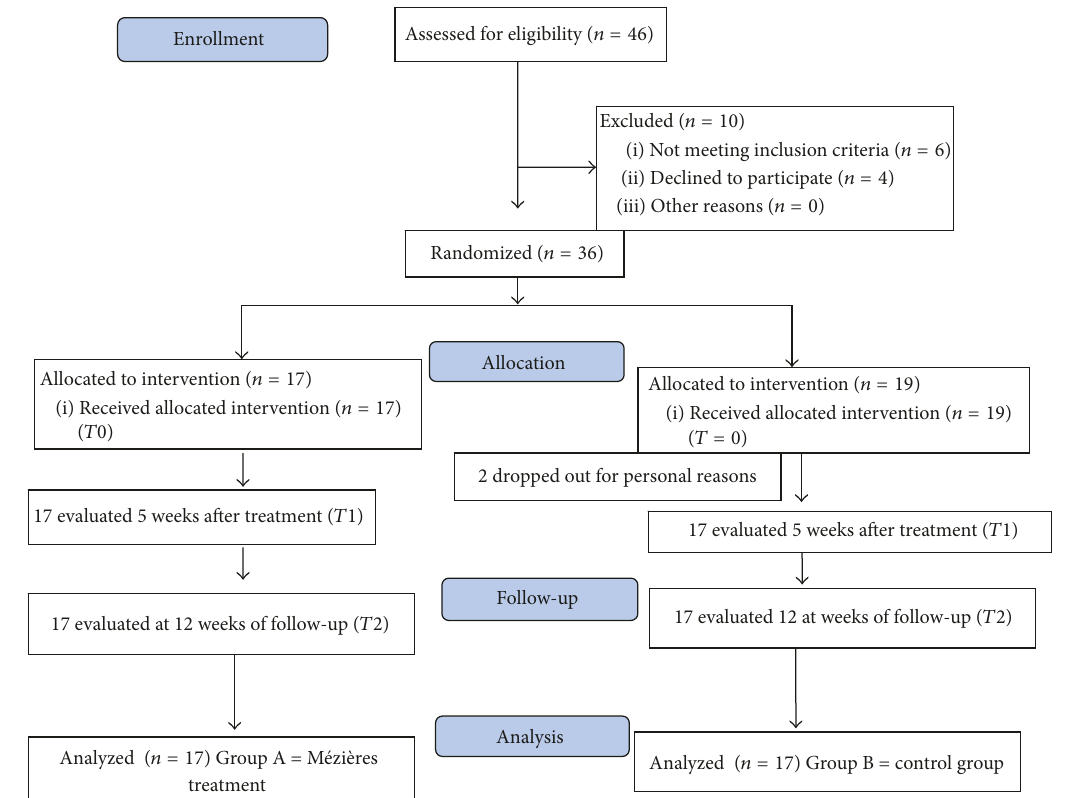
Figure 2: CONSORT flow